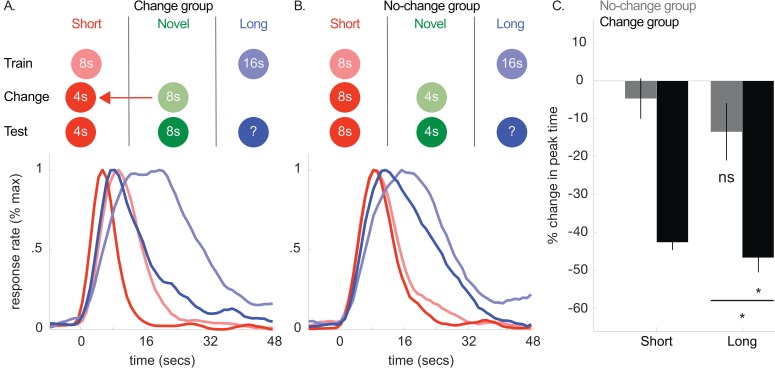
A and B show probe trial responding during initial training and testing for the short and long cues in the change (n = 5) and no-change (n = 5) groups of Experiment 3, respectively.C shows percent change in peak time at test (±SEM) for both groups, relative to initial training.10.7554/eLife.38790.017Figure 4—figure supplement 1—source data 1.Data used to generate Figure 4—figure supplement 1.